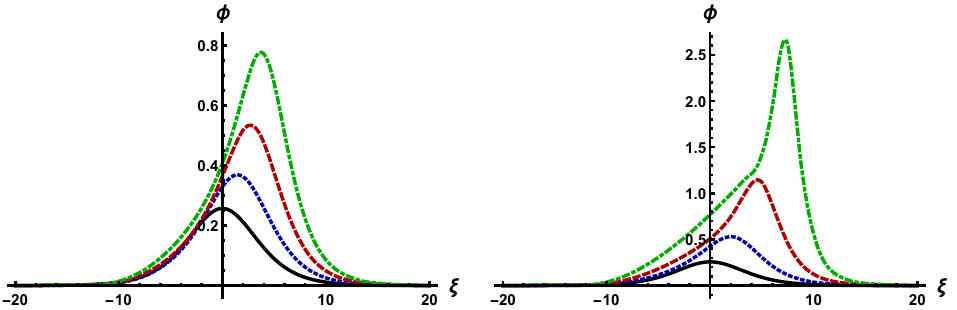
Figure 1. Time evolution of ( left panel ) cylindrical ( ν = 1) and ( right panel ) spherical ( ν = 2.0) nucleus-acoustic (NA) solitary waves in the cold degenerate electron-nucleus plasmas (CDENPs) under consideration for U 0 = 0.1, τ = − 20 (solid line), − 10 (dotted line), − 5 (dashed line), and − 2.5 (dashed-dotted line). See text for